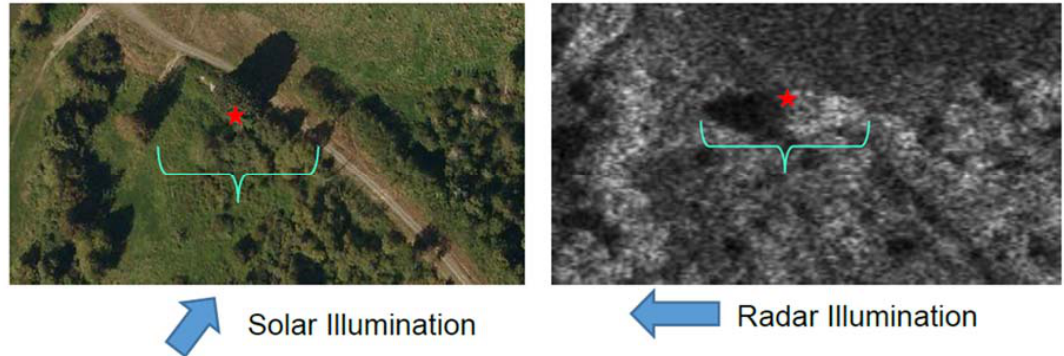
Figure 1. Comparison of an optical image ( a ) and a C ‐ band single look radar image ( b ) of a tall tree. The red star is at the center of the tree base. In the optical image, the solar illumination is from the lower left, resulting in a shadow that extends to the upper right. The image of the tree canopy is centered over the base. In the radar image, the radar illumination is from the right, so the tree’s radar shadow extends to the left, while layover causes the canopy to appear to the right of the base. The radar incidence angle is approximately 45°.